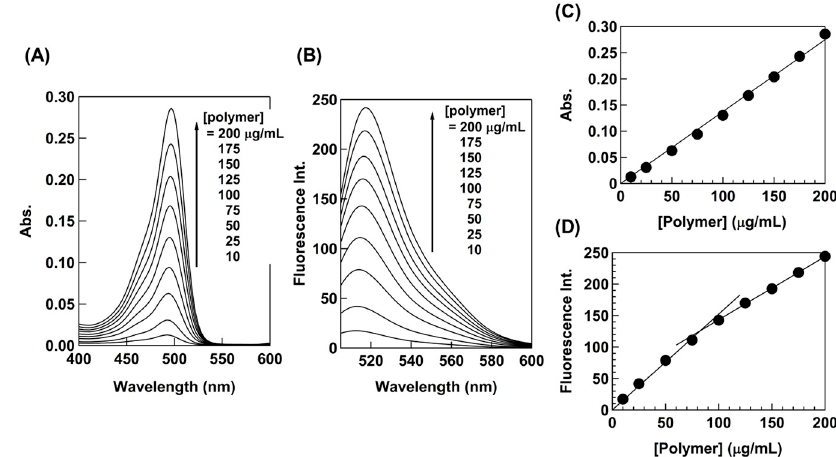
Figure 4. ( A ) Absorption and ( B ) emission spectra of B38 26 containing F-B38 26 in HEPES (1% DMSO), and ( C ) the maximum absorbance and ( D ) maximum fluorescent intensity versus polymer concentration.